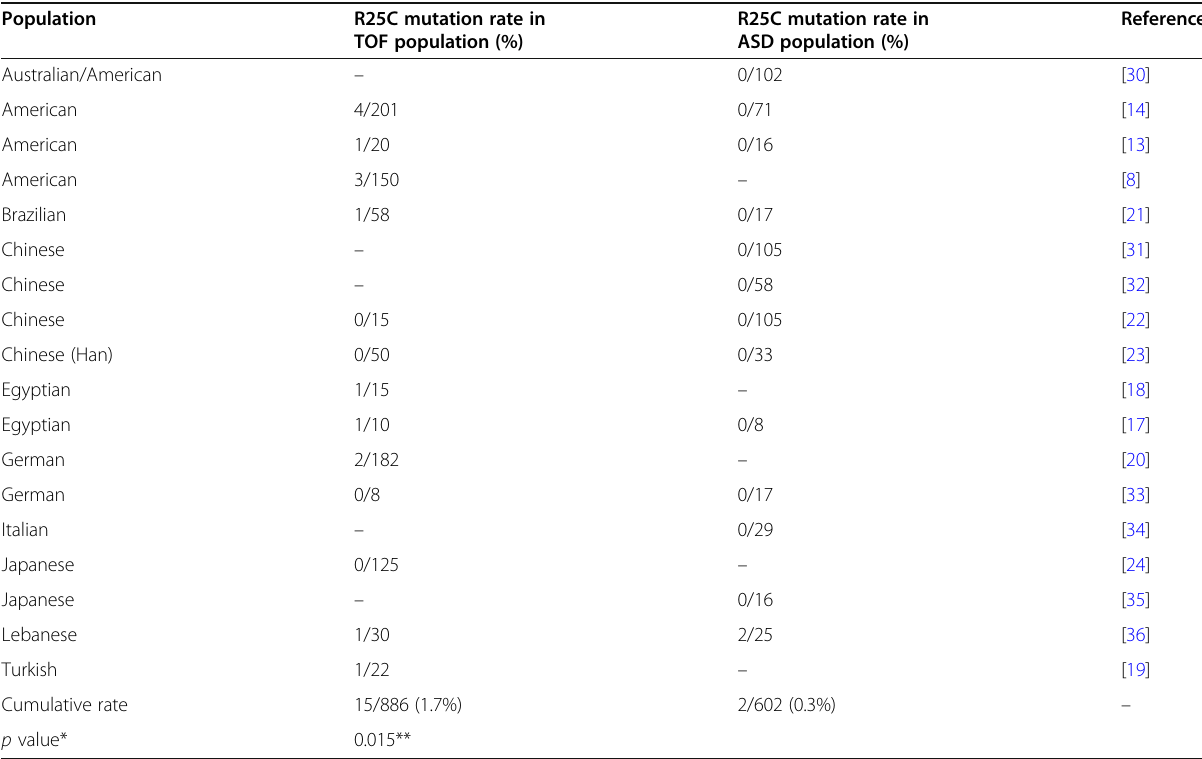
Table 4 Comparison of R25C mutation cumulative rates between TOF and ASD cohorts Population R25C mutation rate in TOF population (%)